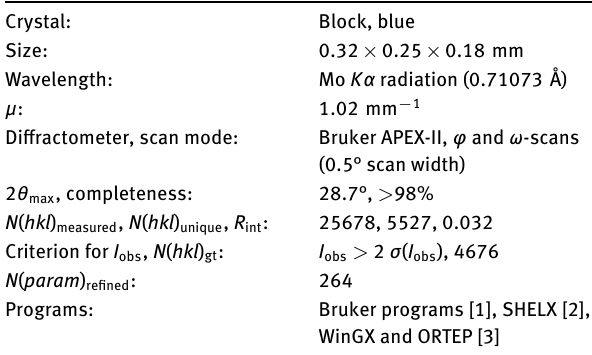
Table 1: Data collection and